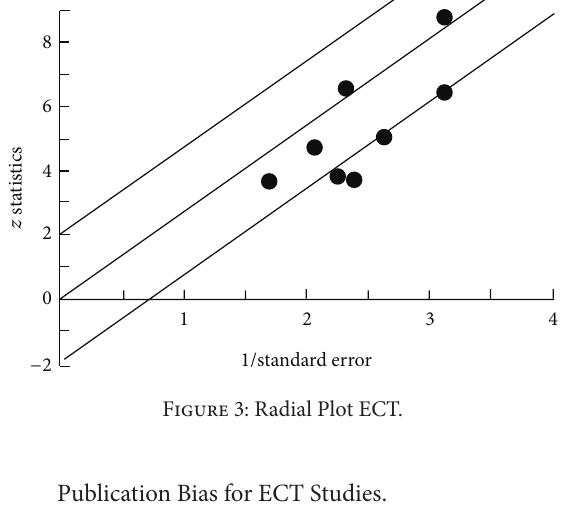
Figure 3: Radial Plot ECT.